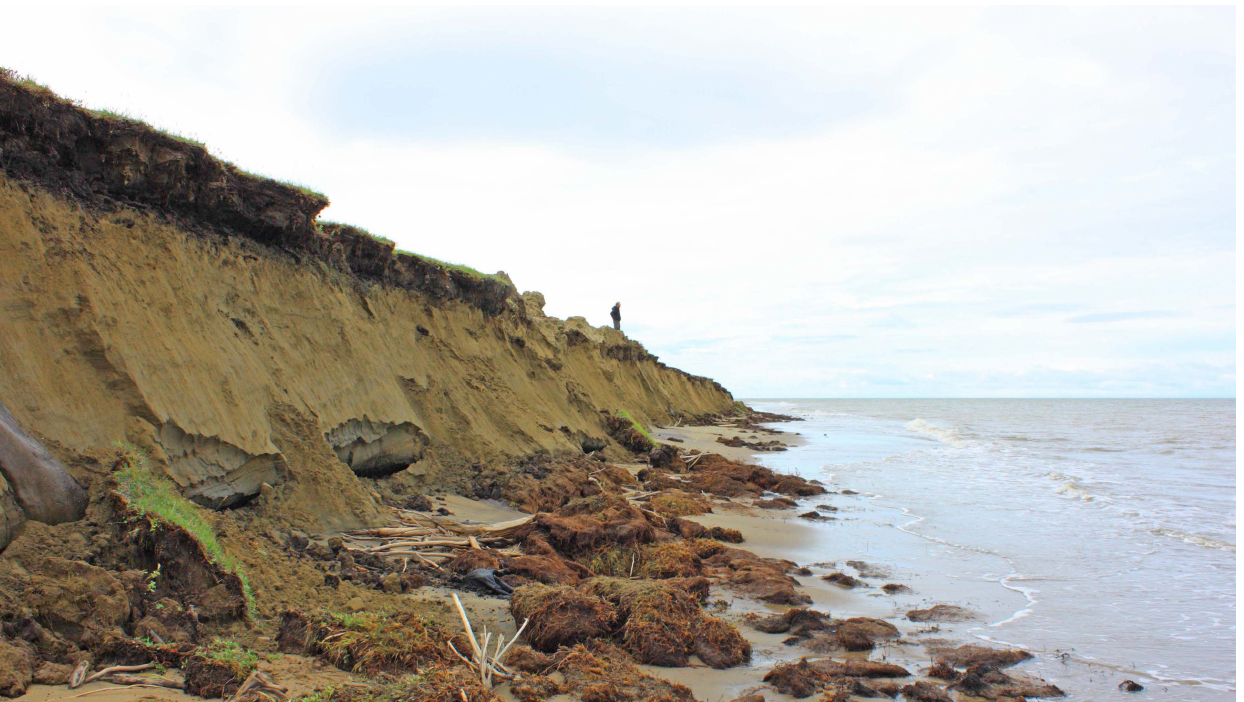
Figure 1. Coastal erosion along a permafrost coastline of the Tuktoyaktuk Peninsula in Canada. Photo taken in July 2012 by Tobias